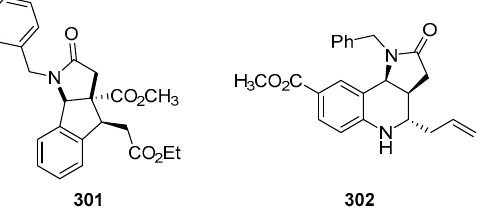
Scheme 91. Synthesis of heliotropamide based on the CCR.